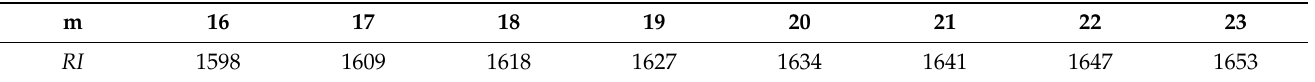
Table A1. Random consistency index ( RI ) [86].